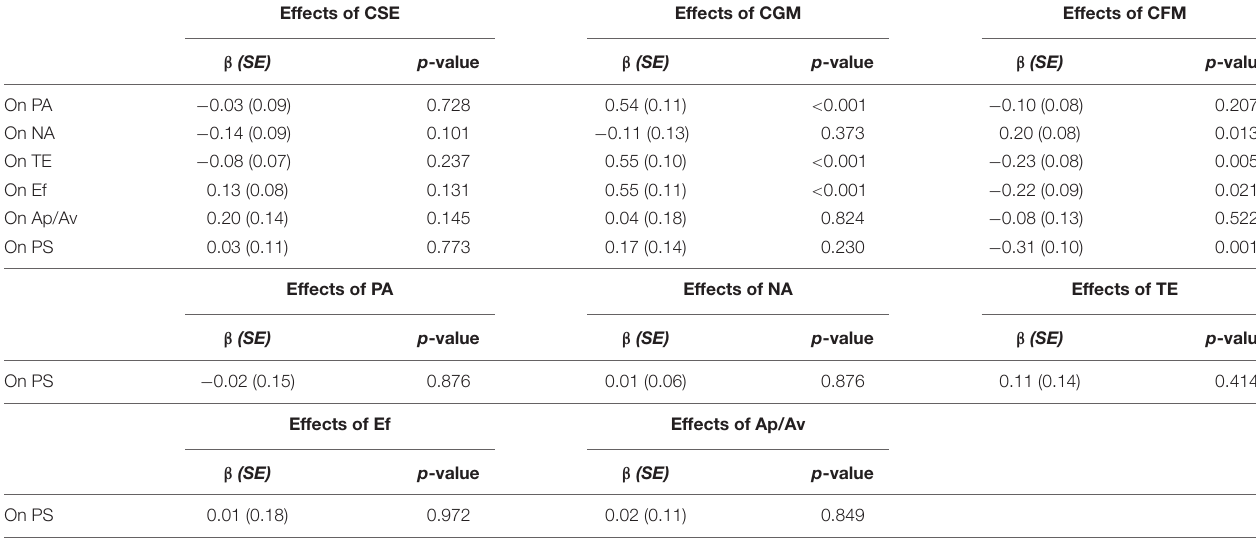
TABLE 4 | Direct effects of Model